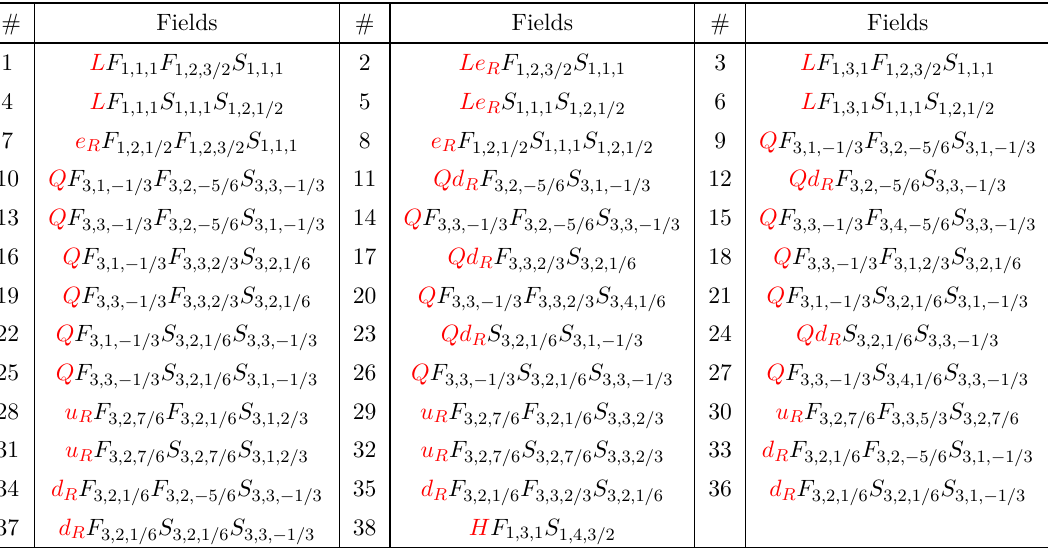
Table 3 . 1-loop neutrino mass models for which some internal field can be a SM fermion. For discussion, see